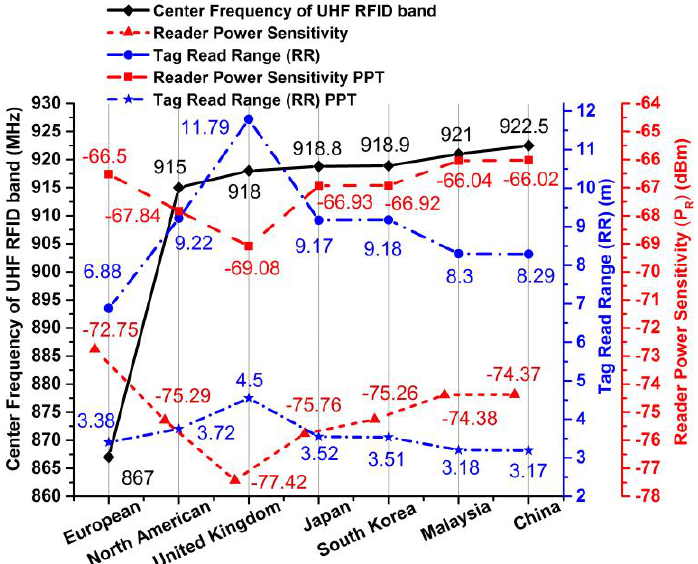
Figure 10. Read range (RR) and reader power sensitivity (P R ) for UHF RFID band countries w.r.t. center frequency ( f c ) for proposed tags and previously published tags (PPT).